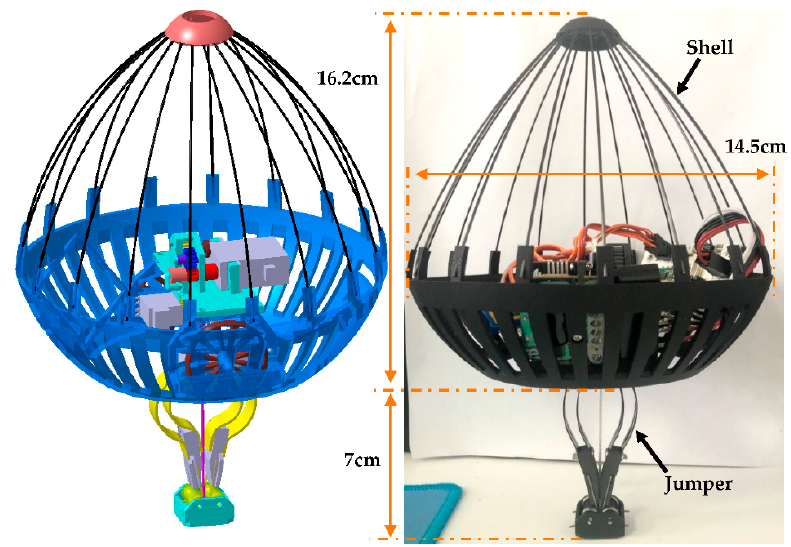
Figure 1. Prototype and model of the robot.